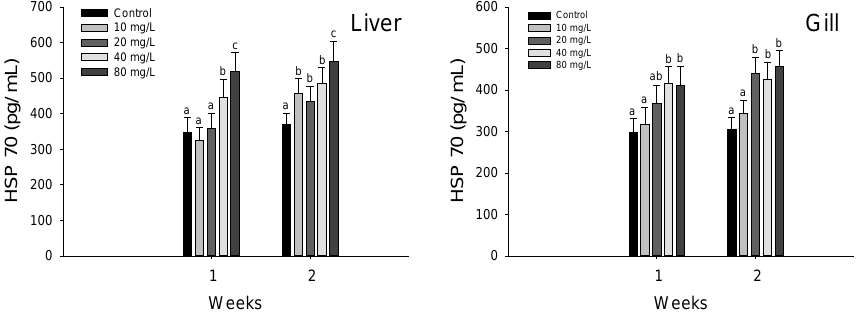
× Epinephelus fuscoguttatus ♂